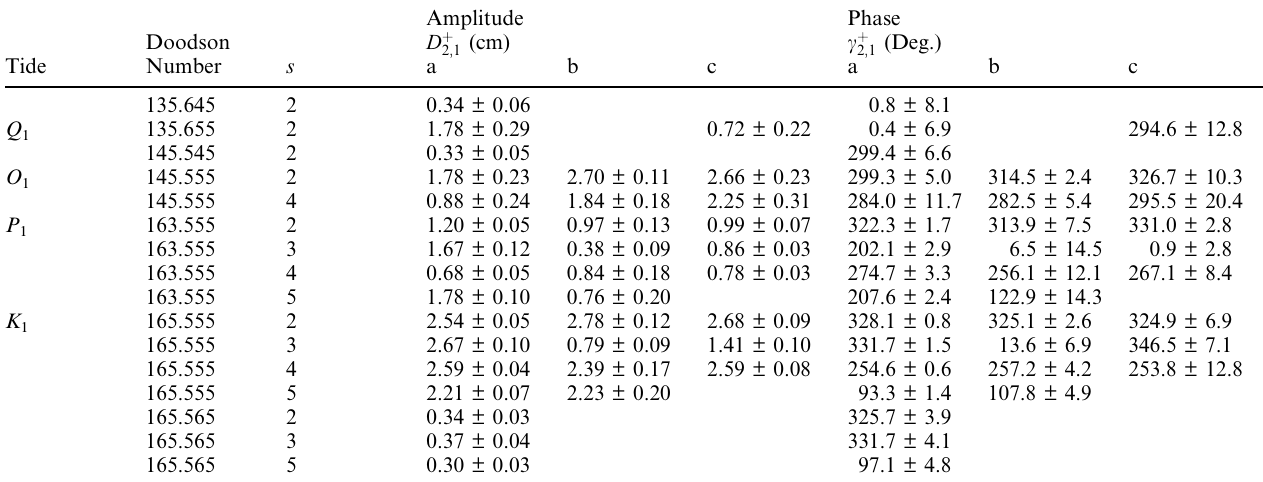
Table 2. Diurnal ocean-tide parameters from the final fitting (a (cid:136) this analysis, b (cid:136) GEM-T3, c (cid:136) Cheng)